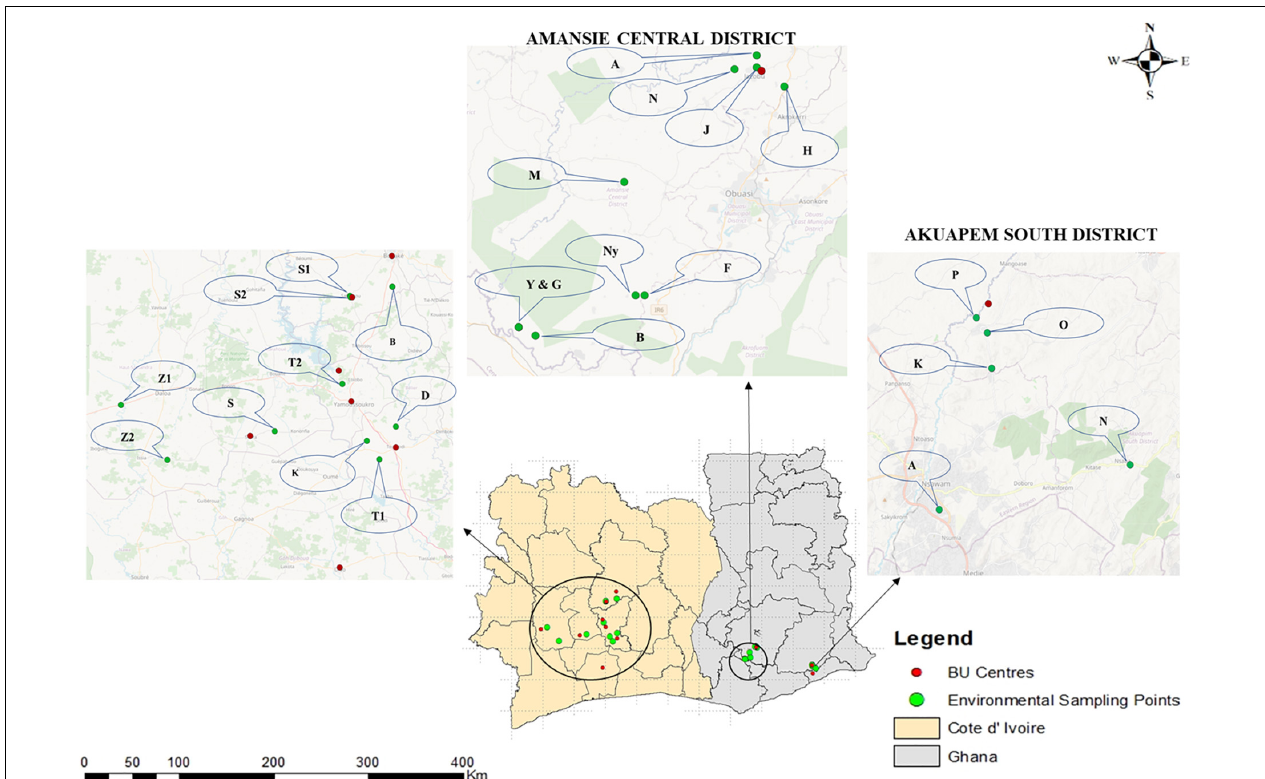
FIGURE 1 | Clinical and environmental sampling sites in Ghana and Côte d’Ivoire. Fifteen communities were selected for environmental sampling from two out of the three districts where clinical sampling was done in Ghana, while 10 BU endemic communities were selected from Côte d’Ivoire. Selection for environmental sampling was done after disease confirmation from BU centers based on areas with a high number of confirmed BU cases and the presence/nearness to a source of water body used by the communities for domestic and commercial purposes based on an administered questionnaire. The environmental sampling sites for Côte d’Ivoire were Zoukougbeu [Gbeulissou-Adjoablassou (Z1) and Grebeu (Z2)], Sinfra [Djenedoufla-Gbalibonou (S), Kongouanou (Djekanou (T2) and Kongouanou (K)], Sakassou [N’zokossou (S1) and Amonlima (S2), Bouake (Adjebretti (B), Toumoudi (Angoda (T1), and Divo (Divo-Sakota (D)]. For Akuapem South District, 5 communities were selected [Pakro (P), Obosono (O), Otukwadwo (K), Alafia (A), and Pokrom (N)], and for Amansie Central, 10 communities were selected [Nkoduase (N), Aboabo (A), Jacobu (J), Homase (H), Mile eleven (M), Fenase No.2 (F), Nyamebekyere (Ny), Gyaman (G), Apaaho (b), and Yaakrakrom